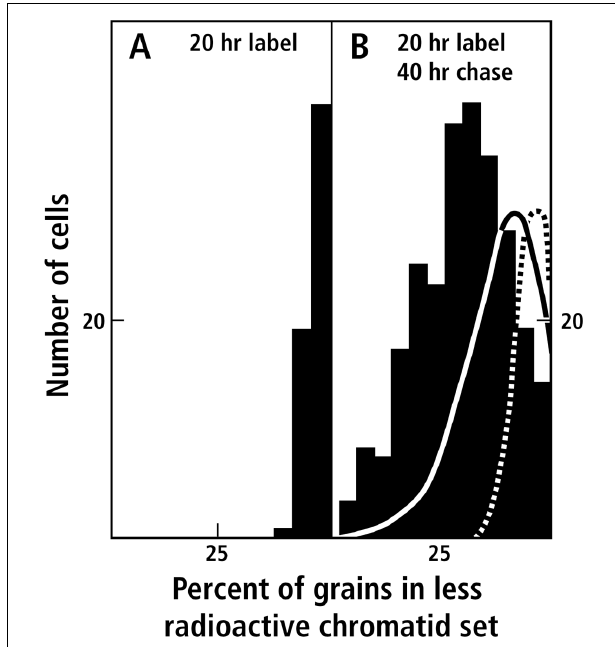
FIGURE 3 | Segregation of radioactively labeled sister chromatids in V. faba root tips (data taken from Figure 3 of Lark, 1967). Radioautographs of anaphase or telophase figures in dividing cells were scored for the number of grains over each sister chromatid set.The distribution of cells is presented as a histogram of the number of cells (ordinate) categorized according to the percent radioactivity in the less radioactive member of the cell’s chromatid pair (abscissa): (A) After 20 h of labeling with radioactive thymidine; (B) after 20 h of labeling with radioactive thymidine followed by 40 h growth in non-radioactive medium. Deviation to the left of 50% indicates the degree of asymmetry.The dashed line indicates the random distribution of 12 radioactive chromatids calculated from the terms of a binomial expansion, assuming no sister chromatid exchange.The solid line is the distribution expected for the random distribution of 12 radioactive chromatids in which sister chromatid exchange results in the redistribution of radioactive material such that on the average 70% of the original chromatid material is not exchanged (for details, see Lark,